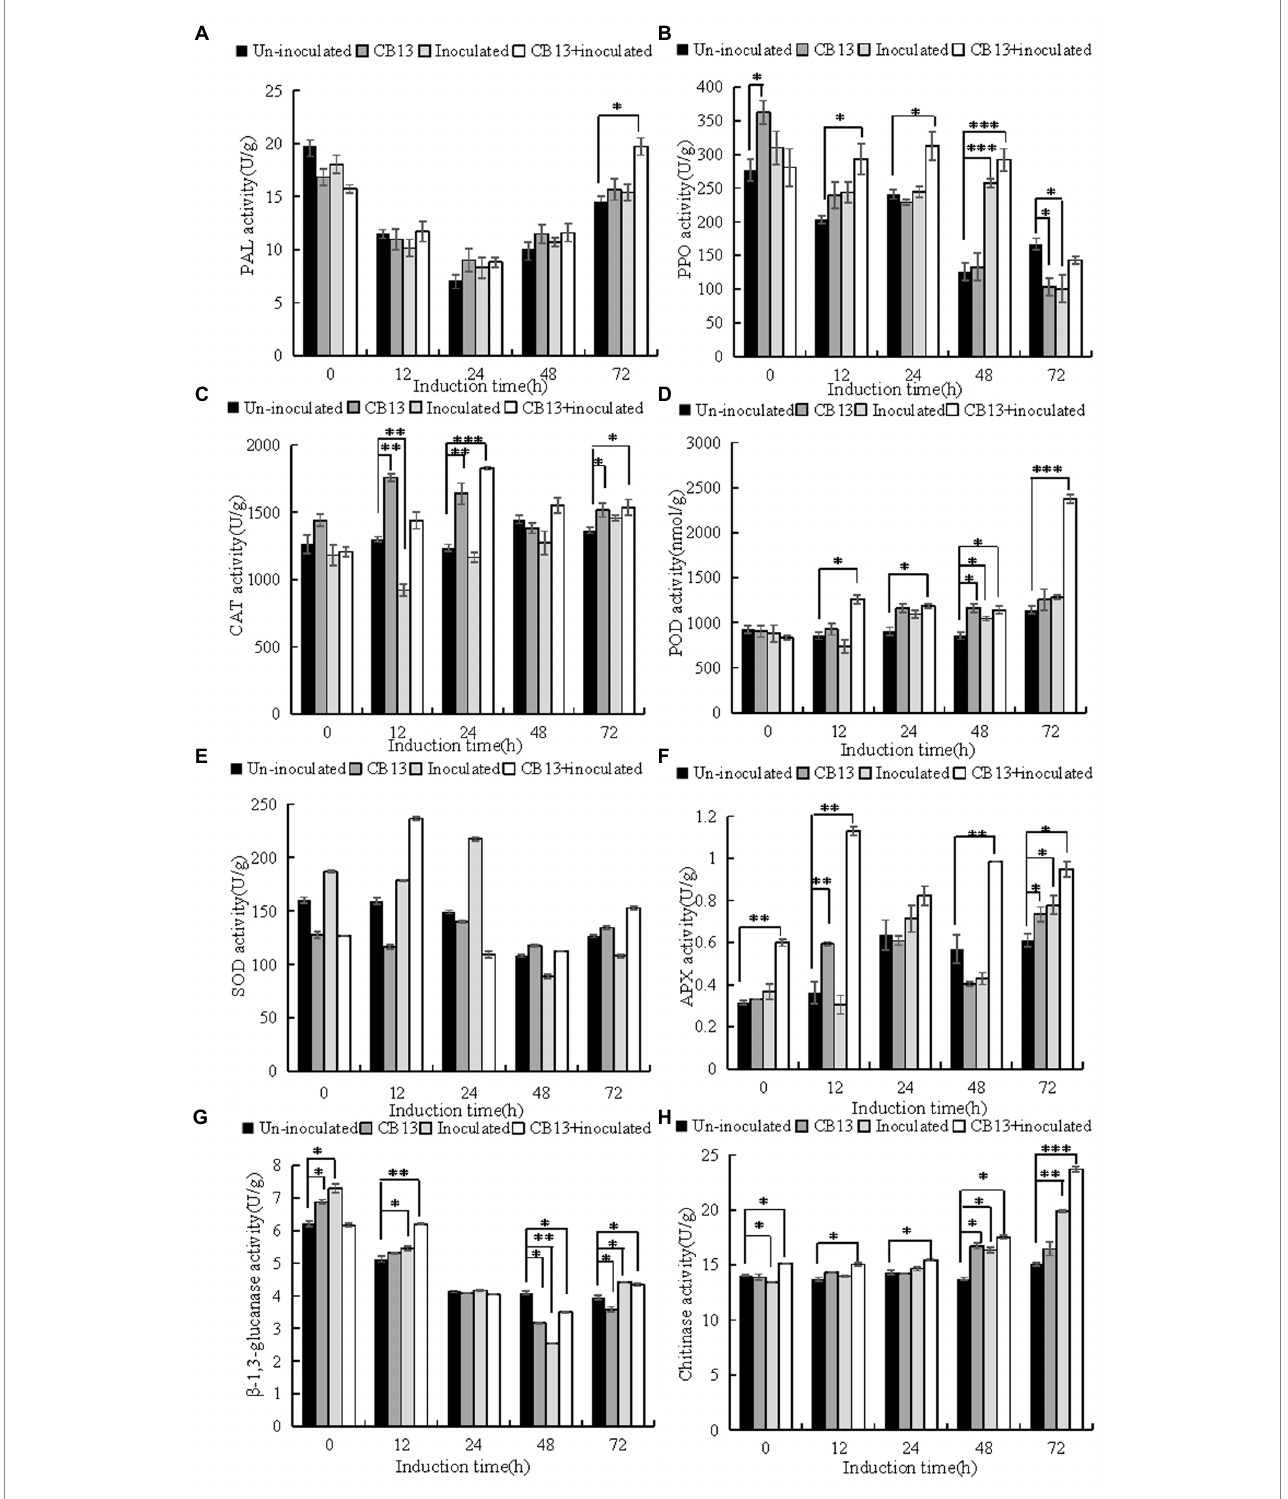
FIGURE 5 Effects of Bacillus velezensis CB13 treatment on the activities of enzymes related to resistance in Sclerotium rolfsii -induced peanut leaves. (A) phenylalanine ammonia-lyase; (B) polyphenol oxidase; (C) peroxidase; (D) catalase; (E) superoxide dismutase; (F) ascorbate peroxidase; (G) β -1,3-glucanase and (H) chitinase. Uninoculated, uninfected, and untreated plants; CB13, peanut plants watered with 20 mL of bacterial inoculum alone; Inoculated peanut plants infected with S. rolfsii alone; CB13 + inoculated, seeds were soaked in bacterial inoculum for 24 h before sowing and then infected with S. rolfsii . Data are the means ± SE of three repeated experiments. Significant differences are shown using asterisks (* p < 0.05, ** p < 0.01, and *** p <